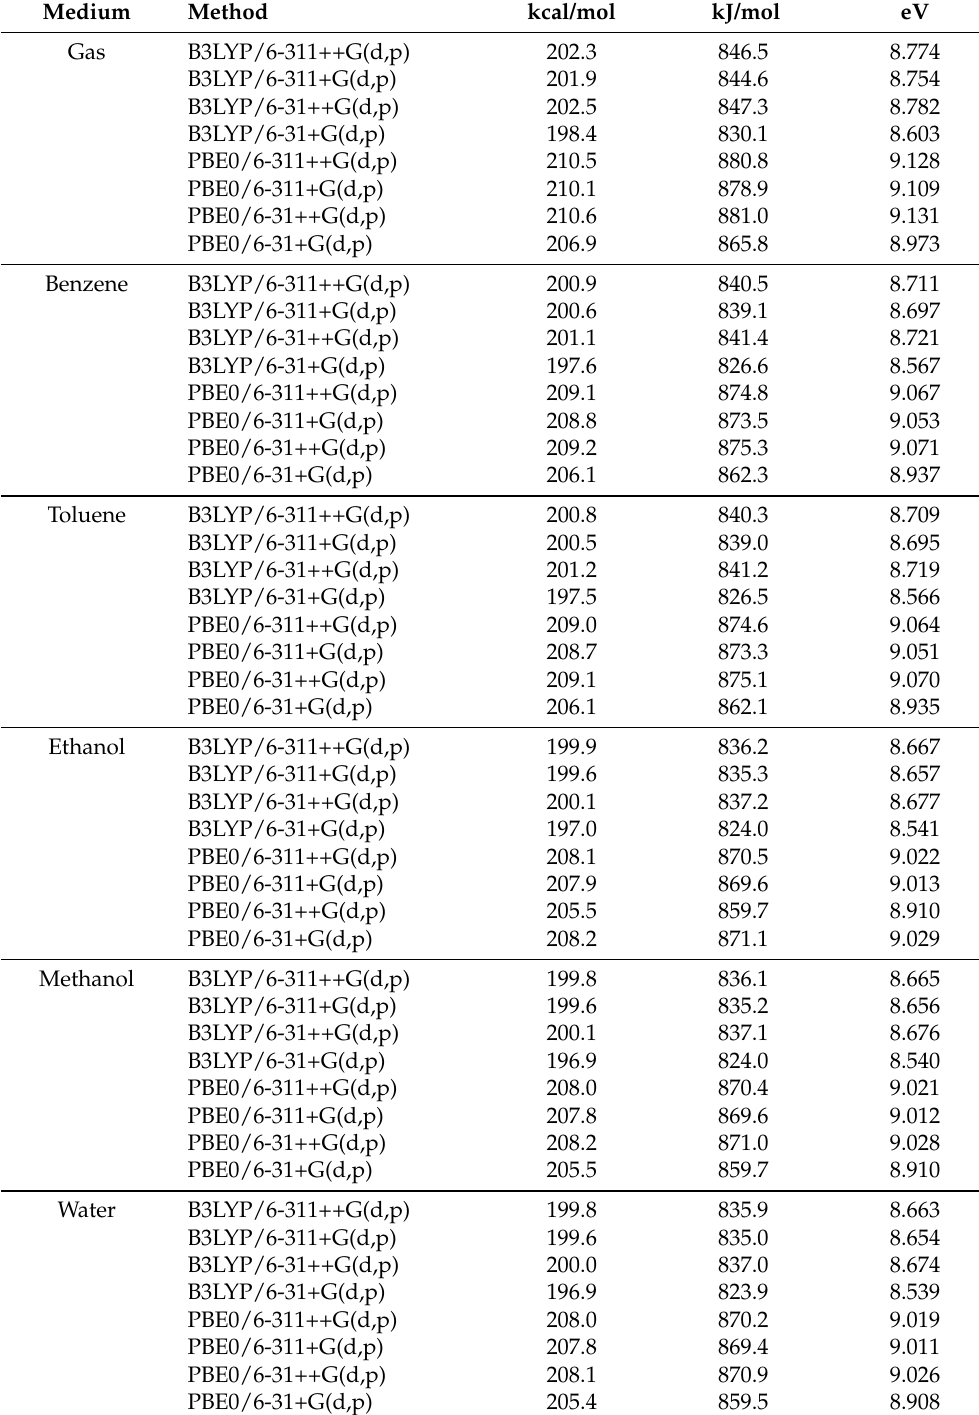
Table 5. Ionization enthalpies (IP H ) of the H-atom in common environments (poorly) approximated as Kohn–Sham HOMO energy with reversed sign (Koopmans’ theorem). As already noted in the caption of Table 2, the results using the basis sets 6-311+G(d,p) and 6-311G(d,p), and 6-31+G(d,p) and 6-31G(d,p) are identical. Likewise, including more polarization functions, G(d,p) → G(2d,2p) or 6-311++(3df,3pd), has no impact on the values presented